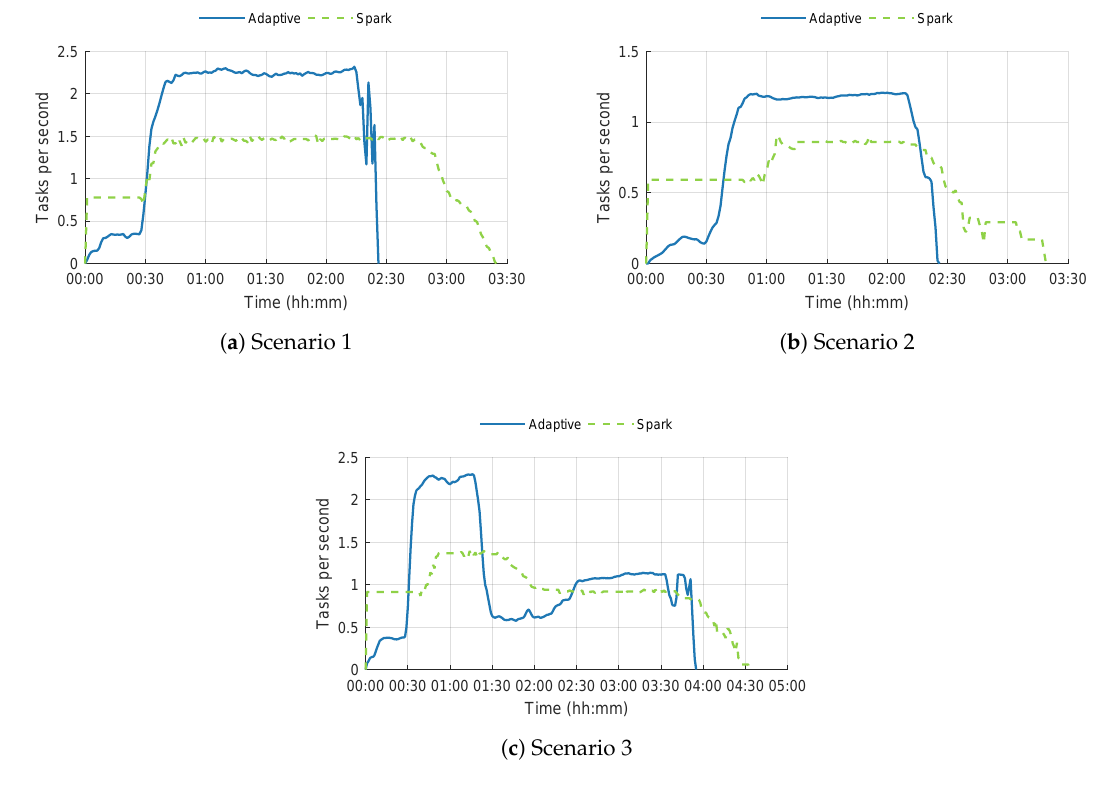
Figure 5. Throughput of the three scenarios with 20 VMs over 5 runs.